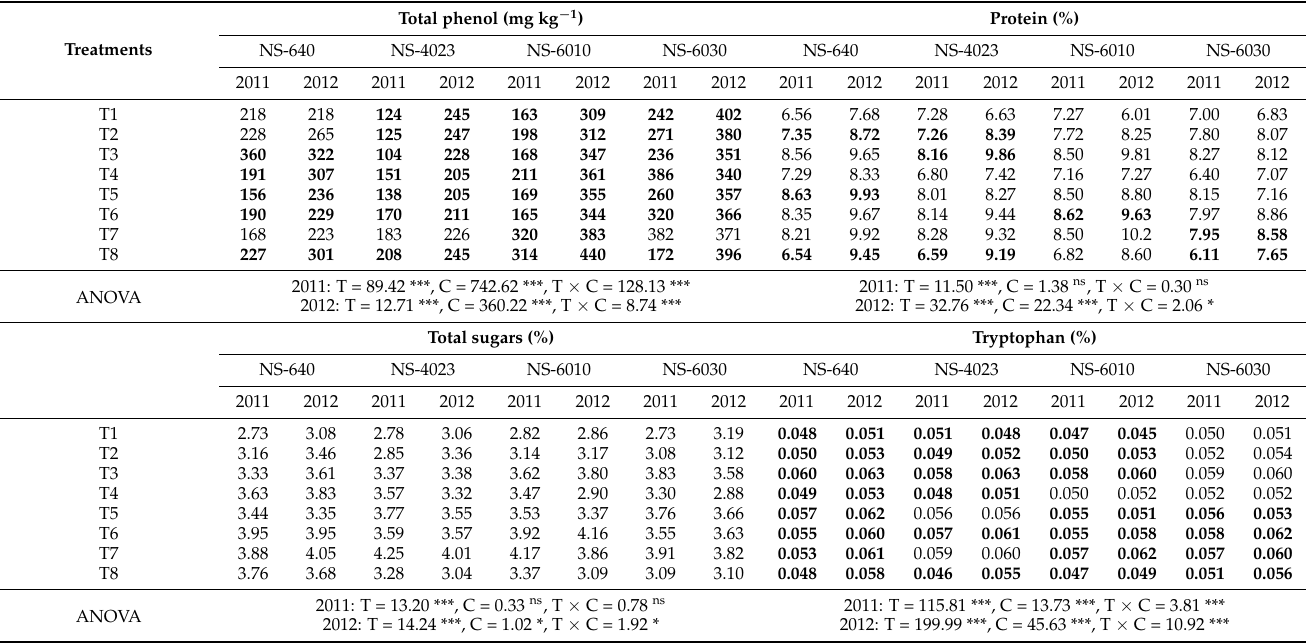
Table 4. Fertilization effects on grain total phenol, protein, total sugars and tryptophan contents of four maize cultivars over two